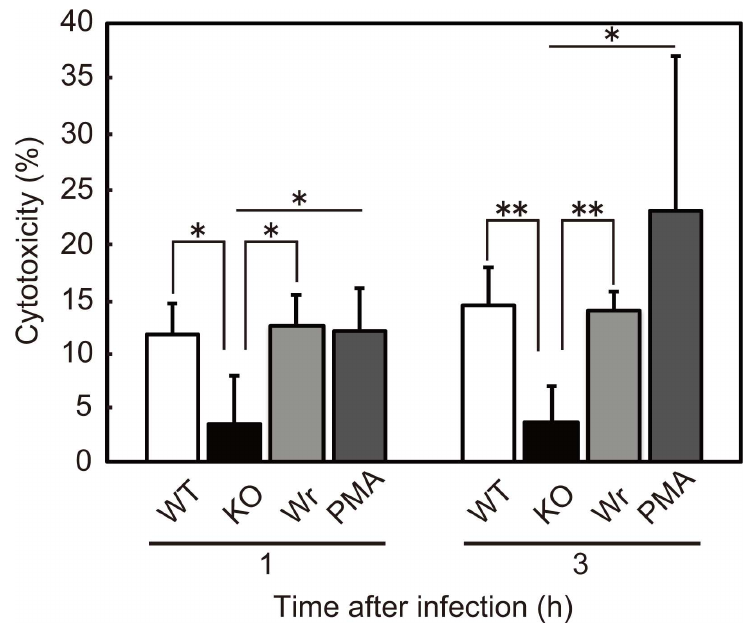
Fig 4. H 2 O 2 produced by S . sanguinis showed cytotoxicity against neutrophils. Human neutrophils were mixed with the S . sanguinis WT, KO, or Wr strain at an MOI of 10. As a positive control, PMA was added at concentrations of 200 nM. Followingincubation for 1 or 3 h, LDH released into culture supernatant was examined.Cytotoxicitywas determinedby relative absorbance, with the absorbance of cells lysed with PBS containing 0.25% Triton X-100 set at 100%. Data are presented as the mean ± SD from 3 independent experiments. Statistically significantdifferences were evaluatedusing one-wayANOVA and Tukey’s multiple comparisontest. * p <